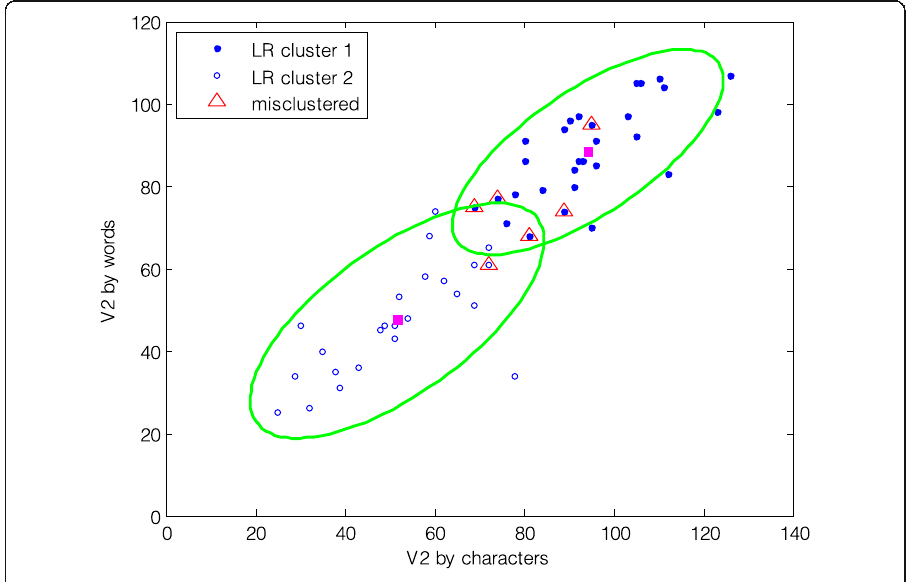
Fig. 2 Differentiation of L1 and L2 speakers using LR measure